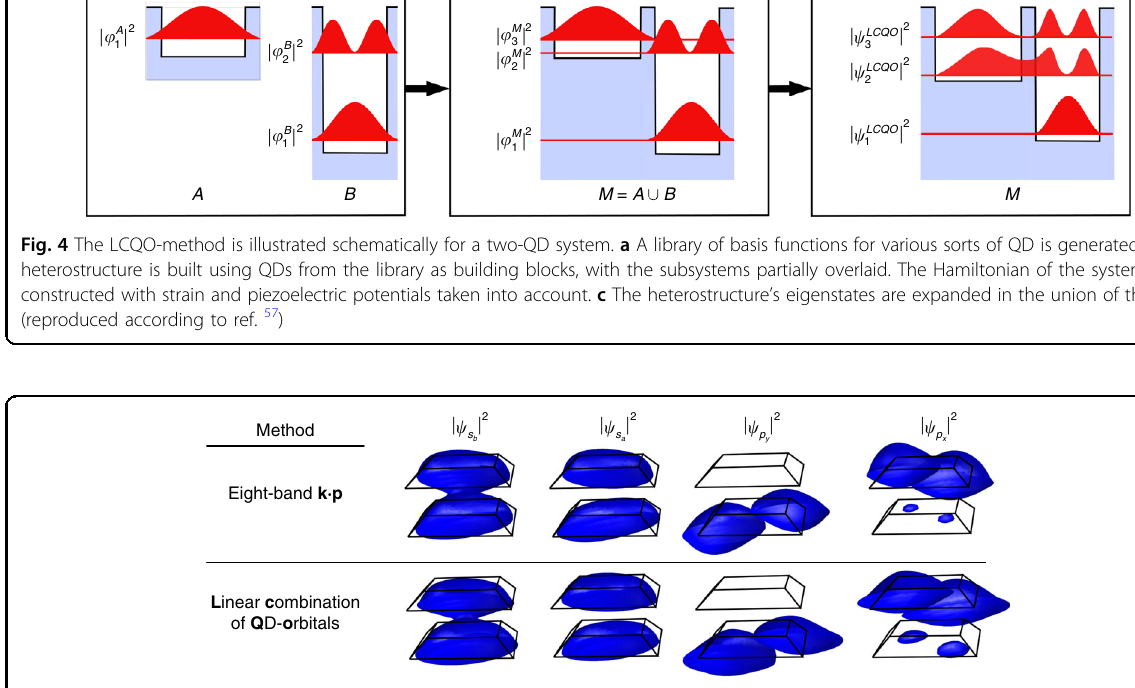
Fig. 5 For a couple of two identical InAs QDs (base diameter (along the diagonal): 20.8 nm, height: 2.8 nm, barrier width: 16 MLs), probability densities of the fi rst four-electron states (isosurface at 90%) are shown for the eight-band k·p model and the LCQO approach, respectively, with binding and antibinding s-type orbitals, followed by p-type orbitals, respectively (reproduced according to ref. 57 )